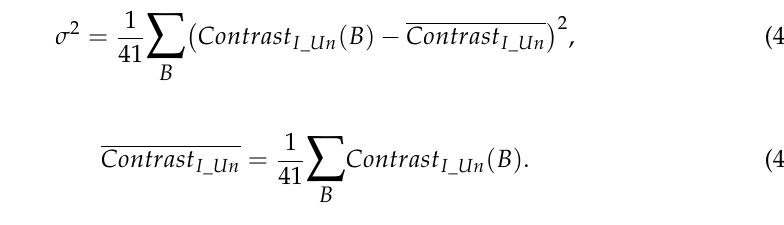
Table 5. Parameters of sources of reveal emissions used in the tests.